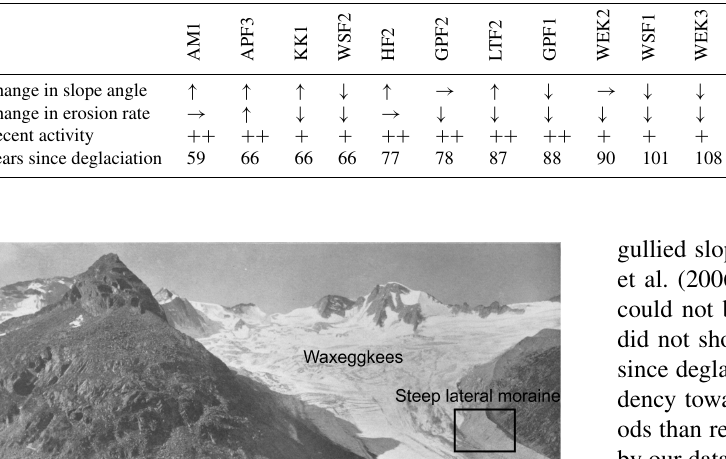
Table 6. Overview over the slope angle, erosion rate, recent activity, and years since deglaciation for all investigated moraine sections. Change in the slope angle is indicated if it was more than 1 ◦ (median) between ca. 1950 and 2018. Change in the erosion rate is indicated if it exceeds 1.8cm between the first and third period. Recent activity is based on time period 3 ( ++ for > 4cmyr − 1 , + for 2–4cmyr − 1 and 0 for 0–2cmyr − 1 ).